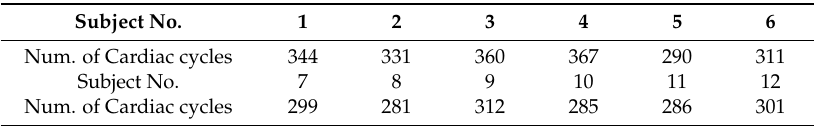
Figure 3. A portion of synchronous signals. They are scaled in amplitude for visual inspection. Table 1. Summary of cardiac cycles involved in this work for each subject.